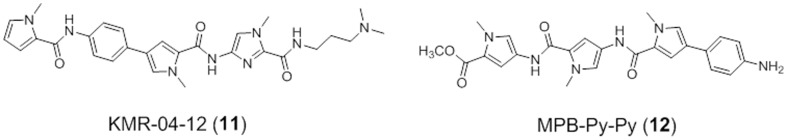
Structures of the G-quadruplex-interacting ligand KMR-04-12 (11), and the MPB-Py-Py fragment (12) identical to the C8-side chain of KMR-28-18 (5).The MPB moiety in the centre of KMR-04-12 (11) provides the molecule with a U-shaped 3-dimensional shape suitable for binding to G-quadruplex DNA.